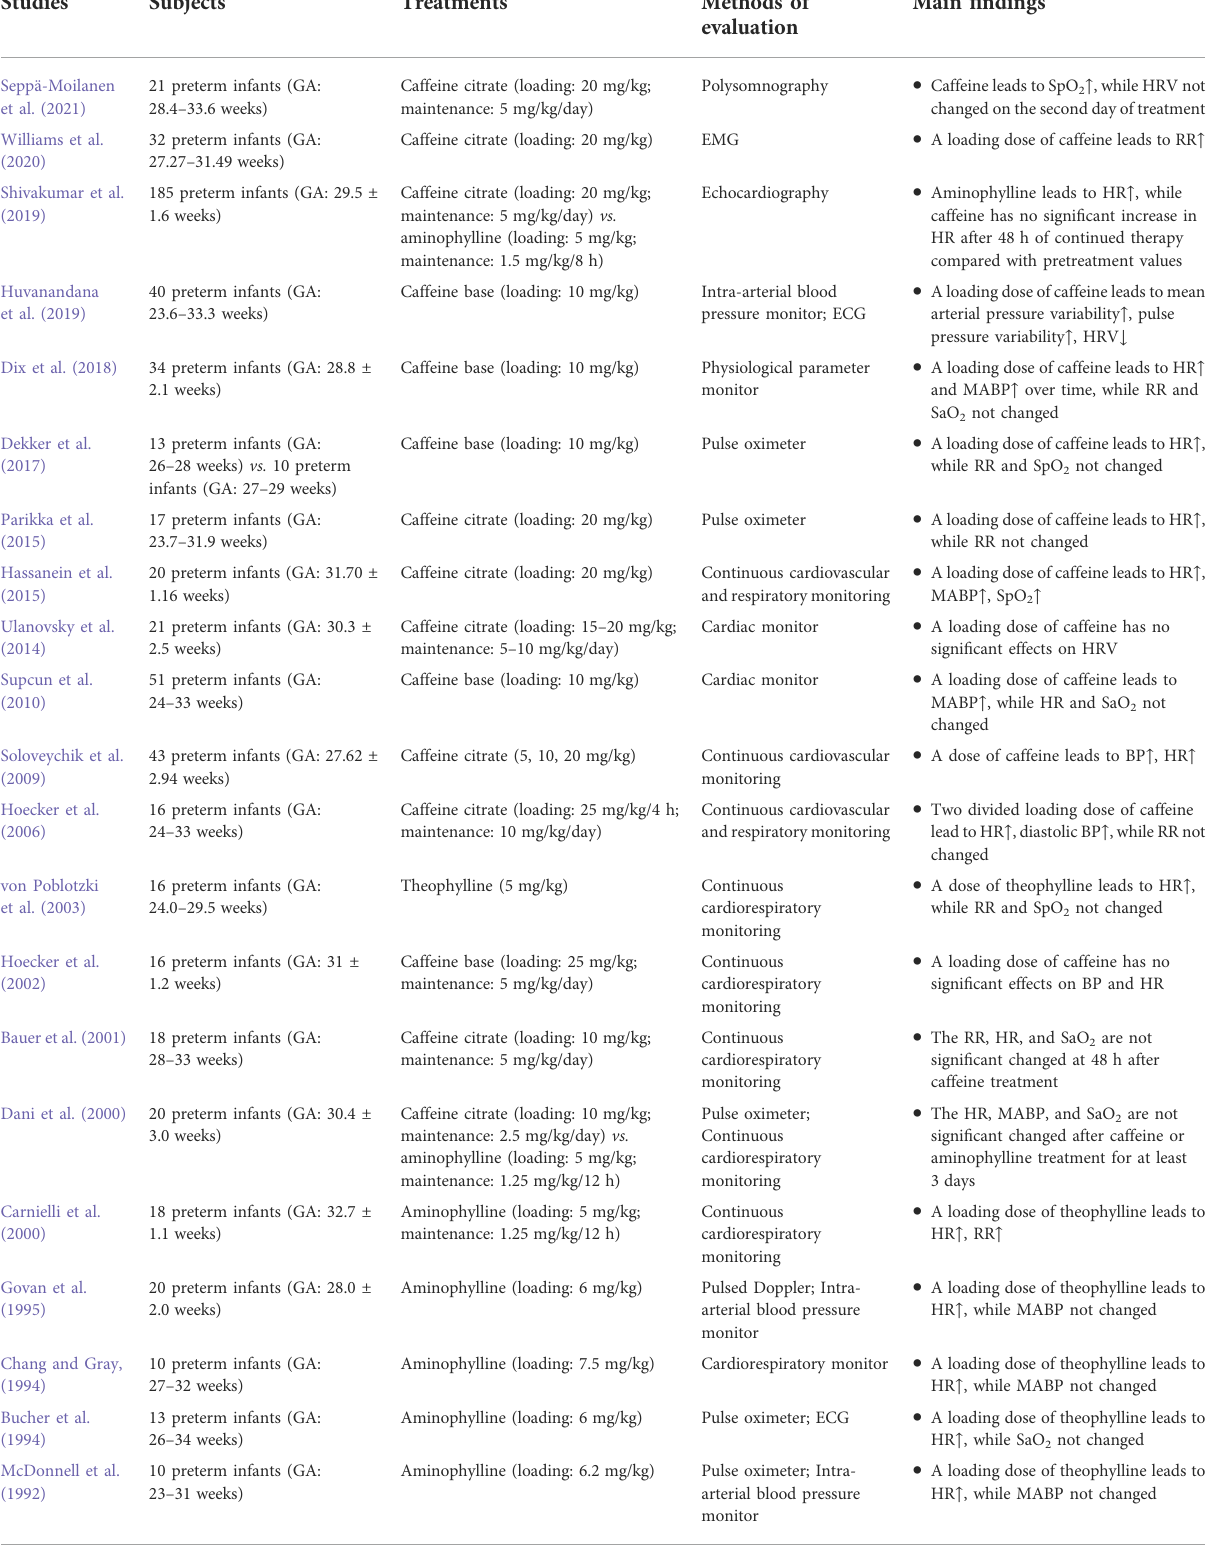
TABLE 6 Studies about the effects of methylxanthine on cardiorespiratory rhythms in preterm infants.